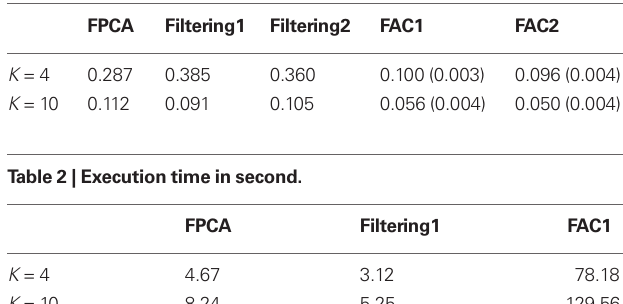
Table 1 | Misclassification rates on the reduced data (classifier: logistic regression).